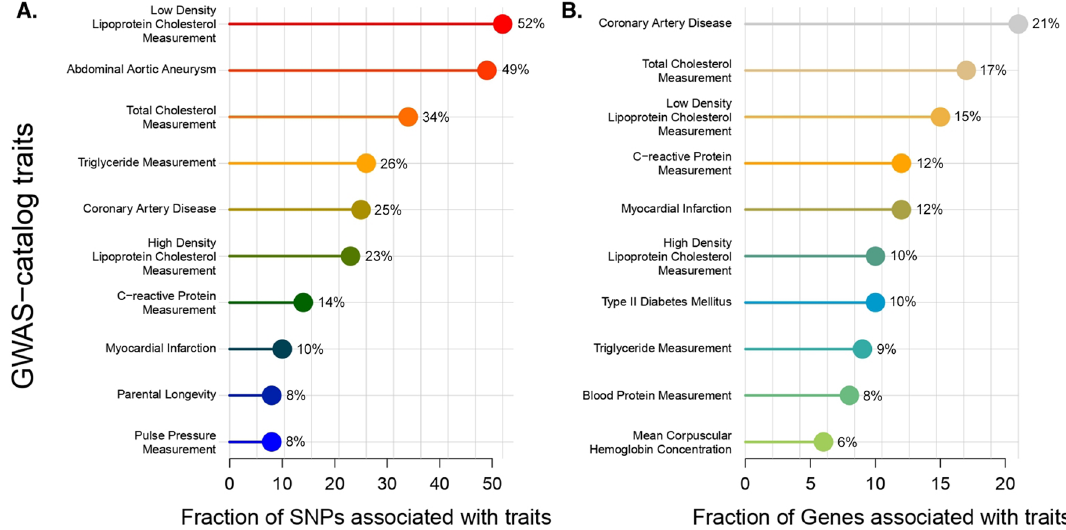
Figure 3. GWAS traits of AAA SNPs. GWAS-catalog Traits of 86 SNPs and Genes Associated with AAA, shown in a fraction of ( A ) total SNP (86) or ( B ) genes (130). The numbers presented are fractions of the GWAS-catalog traits from all tested SNPs or